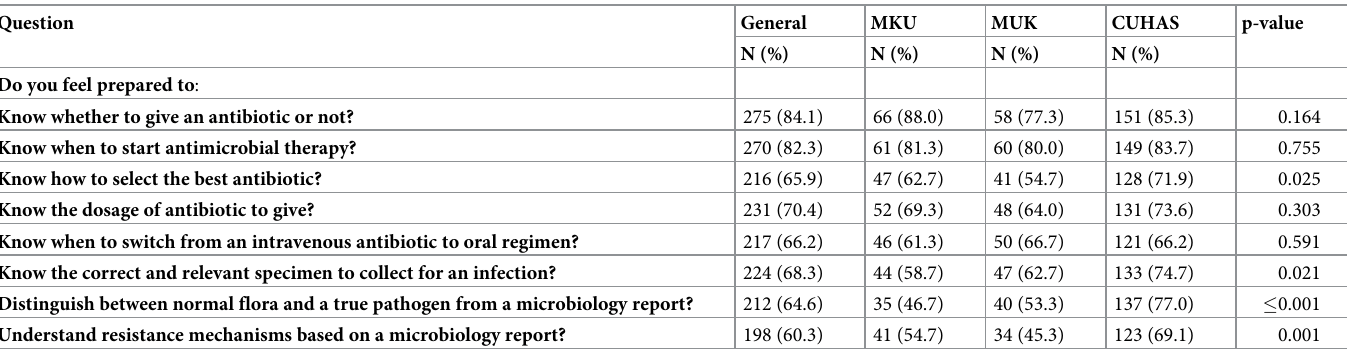
Table 6. Preparedness to use antibiotics